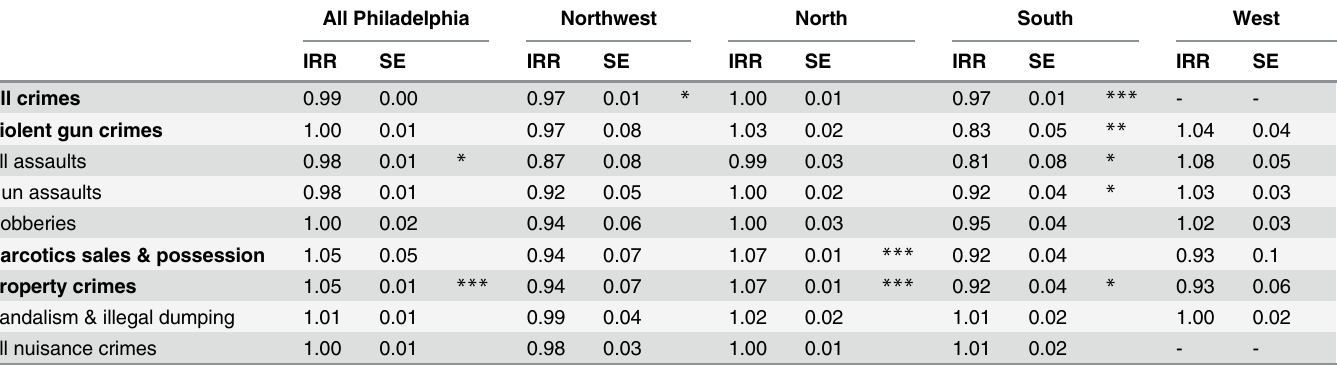
Table 2. Adjusted Difference-in-Differences Estimates of Violation Compliance on Census-Tract Level Crime Outcomes, by City Section, Philadel- phia, PA, January 2010 – April 2013 1 . All Philadelphia Northwest